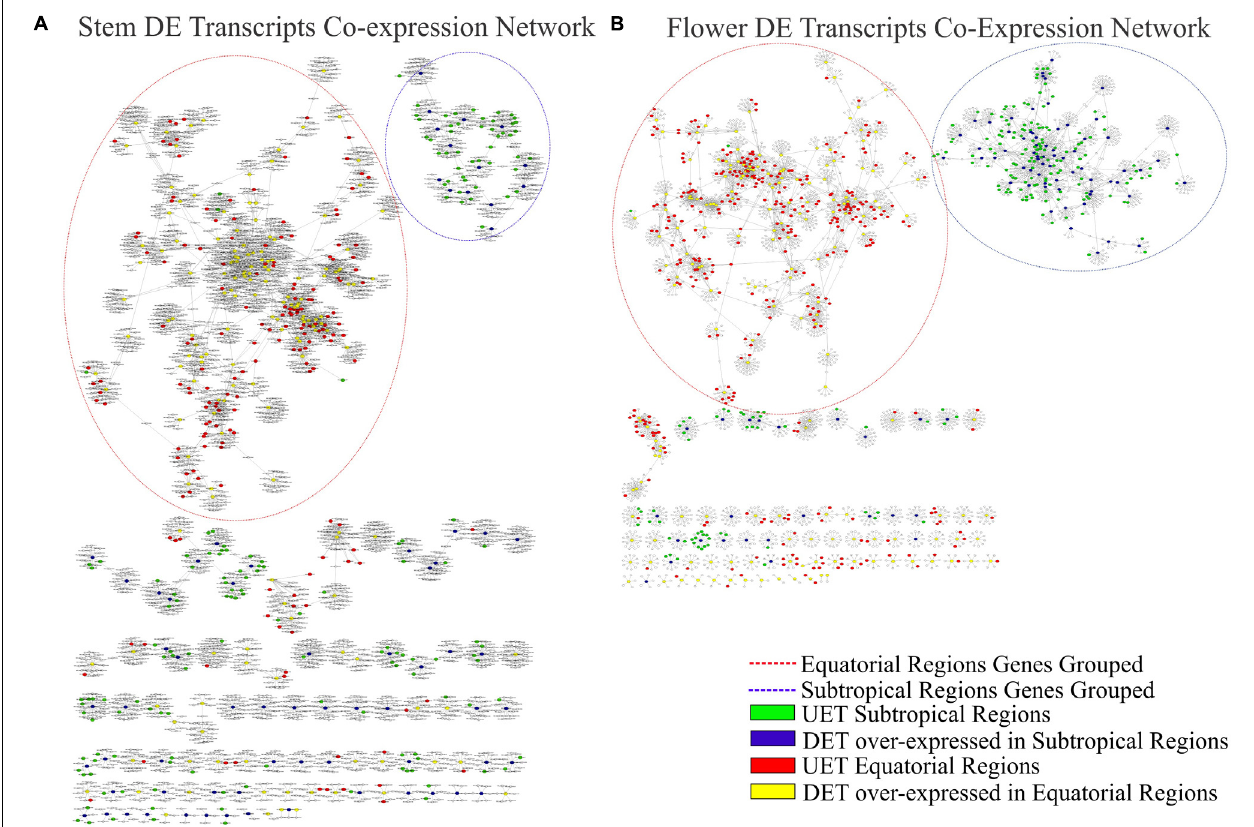
FIGURE 7 | Correlation networks of transcript expression in Rhizophora mangle . Circular nodes represent transcripts and edges represent the correlation between pairs of transcripts. The figures show differentially expressed transcripts (DETs) between populations and their first neighbors. A blue circle highlights one of the largest clusters of these networks, with a predominance of UETs and over-expressed transcripts detected in subtropical samples. A red circle highlights one of the largest clusters of these networks, with a predominance of UETs and over-expressed transcripts detected in equatorial samples. (A) Co-expression network of stem transcripts. (B) Co-expression network of flower